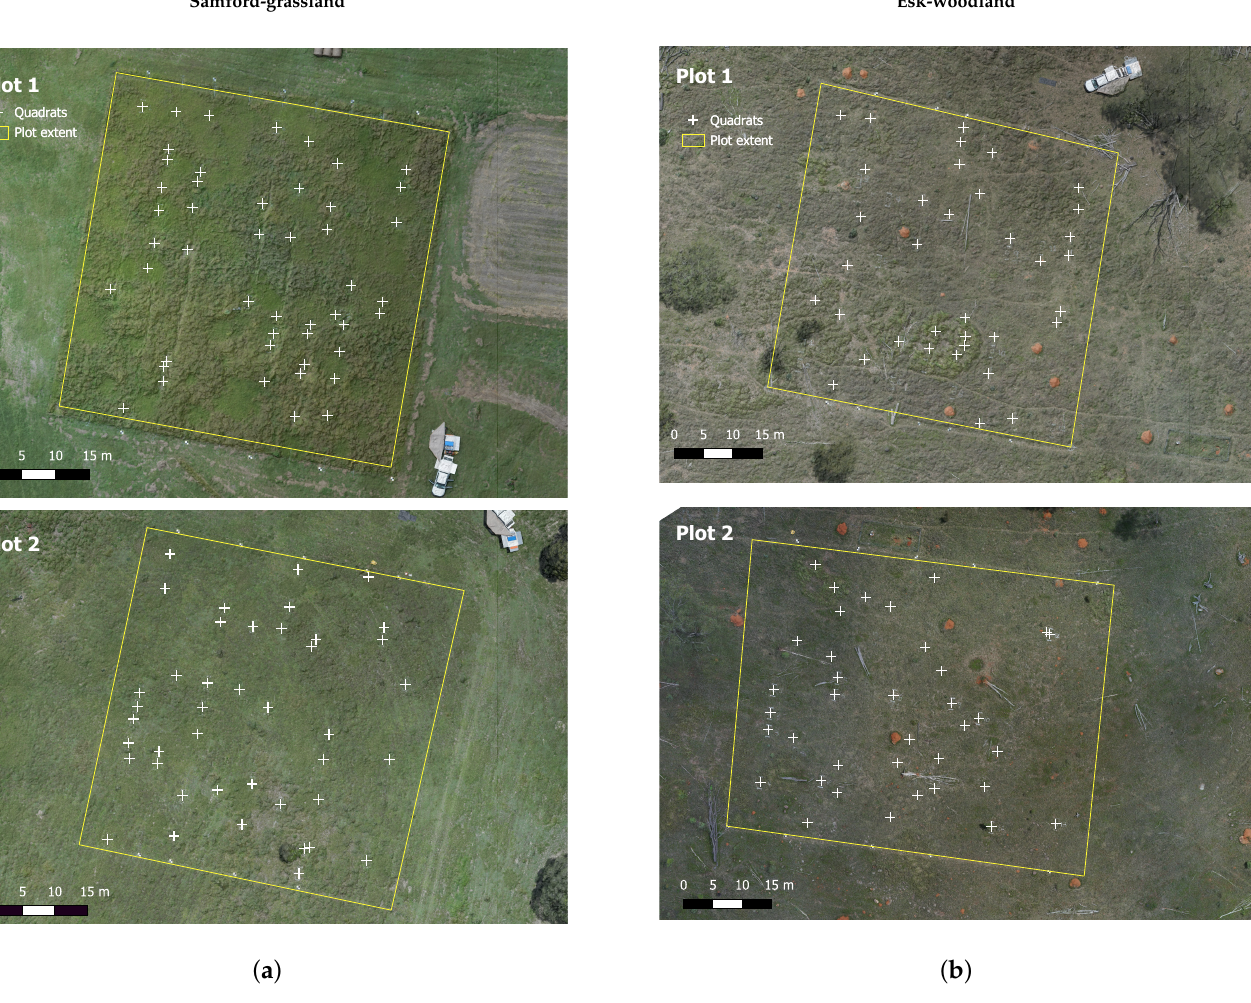
Figure 3. Illustration of the grassland field site plots one and two within the Samford Ecological Research Station ( a ) and the woodland field site plots ( b ) near the township of Esk. White markers illustrate the locations of the quadrats sampled during the growing season.